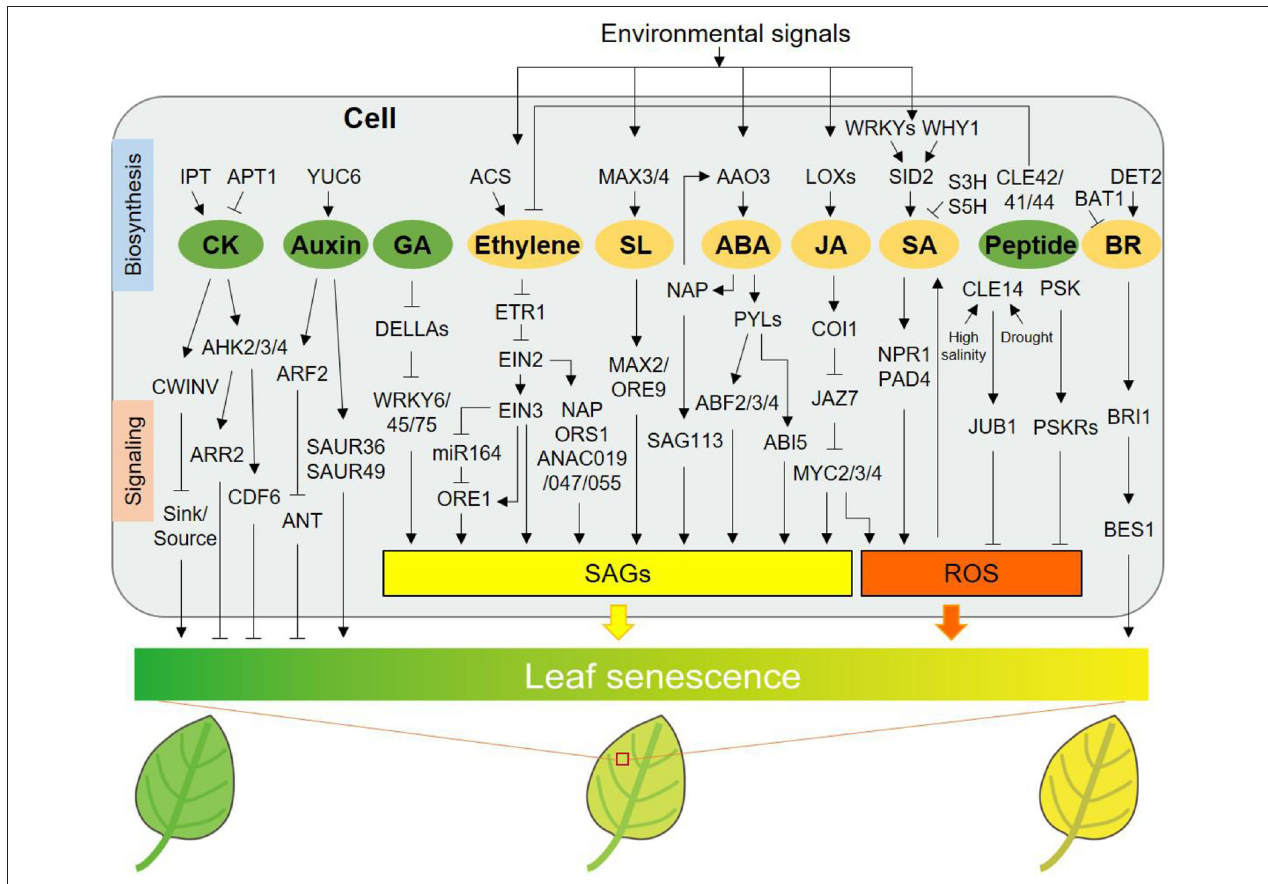
FIGURE 1 | Regulation of leaf senescence by classical and peptide hormones. IPT and APT1 participate in CK biosynthesis and catabolism, respectively. AHK2/3/4, ARR2, and CDF6, signaling components of CK, delay leaf senescence. CWINV (cell-wall invertase) delays senescence via regulating sink-source relations. YUC6 delays leaf senescence by increasing auxin biosynthesis, while ARF2 and SAUR36/49 promote leaf senescence by transmitting auxin signal. ANT, a downstream component of ARF2, postpones senescence phenotype. DELLA proteins delay processes of GA-induced leaf senescence via inhibiting functions of various WRKYs. ACS is involved in ethylene biosynthesis. ETR1, one receptor of ethylene signaling pathway, is involved in ethylene-induced leaf senescence. Ethylene promotes leaf senescence through EIN2-EIN3-miR164-ORE1 pathway or several EIN2 downstream components, including NAP, ORS1, and ANAC019/047/055. SL accelerates leaf senescence via functions of MAX2/ORE9. NAP can elevate ABA biosynthesis via inducing AAO3 expression, and ABA-NAP-SAG113 pathway promotes leaf senescence. The receptors of ABA, PYLs and the downstream TFs, ABF2/3/4 and ABI5 all promote ABA-triggered leaf senescence. LOXs promote leaf senescence by increasing JA content under stress conditions. JA promotes senescence via signaling pathway relating to COI1, JAZs, and MYC2/3/4, with increased expression of SAG s and enhanced ROS. WHY1 and several WRKYs promote SA content through elevating expression of SID2, a key synthase for SA biosynthesis. S3H and S5H catalyze SA to decline activated form of SA. SA promotes leaf senescence dependent on NPR1 and PAD4, associated with ROS. Peptide hormones including CLE42/41/44, CLE14, and PSK delay leaf senescence. CLE42/41/44 function redundantly to delay senescence via antagonizing with ethylene pathway. CLE14 is induced by high salinity and drought stresses and reduces ROS level via transcriptional activation of JUB1, a NAC TF. PSK may be perceived by its receptor PSKRs to contribute to ROS scavenging. In addition, GA, ethylene, SL, and ABA are also associated with regulation of a series of SAG s expression. DET2 contributes to BR biosynthesis and BAT1 inactivates BR. BR accelerates leaf senescence through signaling transduction involving positive regulators, BRI1 and BES1. Hormones including ethylene, SL, ABA, JA, and SA play significant roles in integrating environmental signals into the regulation of leaf senescence. Hormones presented in green ellipses including CK, auxin, GA, and mentioned peptides delay leaf senescence, whereas ethylene, SL, ABA, JA, SA, and BR in orange ellipses promote leaf senescence, according to phenotypic changes caused by exogenous application. SAGs, senescence-associated genes; ROS, reactive oxygen